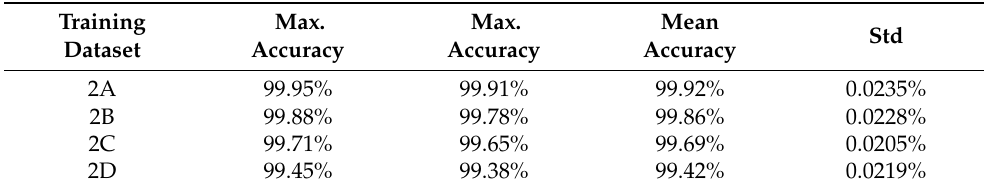
Table 8. The testing results of the confusion matrix of the best prediction WAR-DIC model trained on dataset 2A.